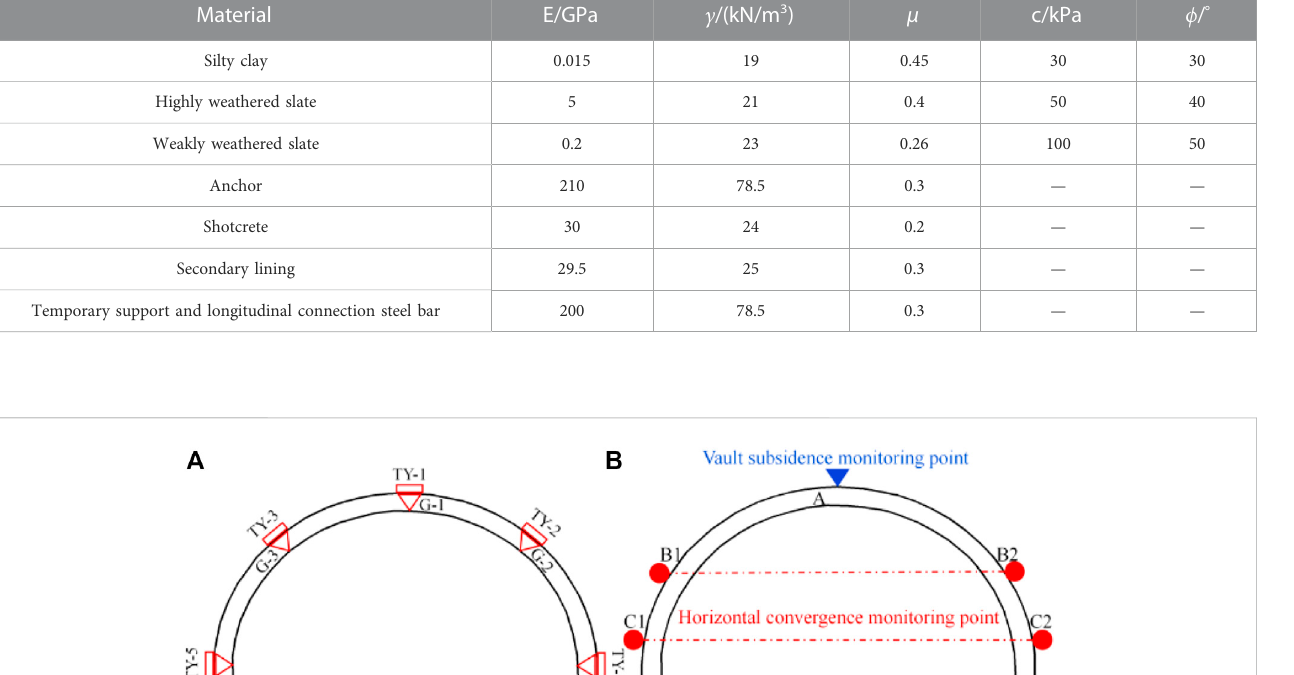
TABLE 2 Calculation parameters used in the model. Material